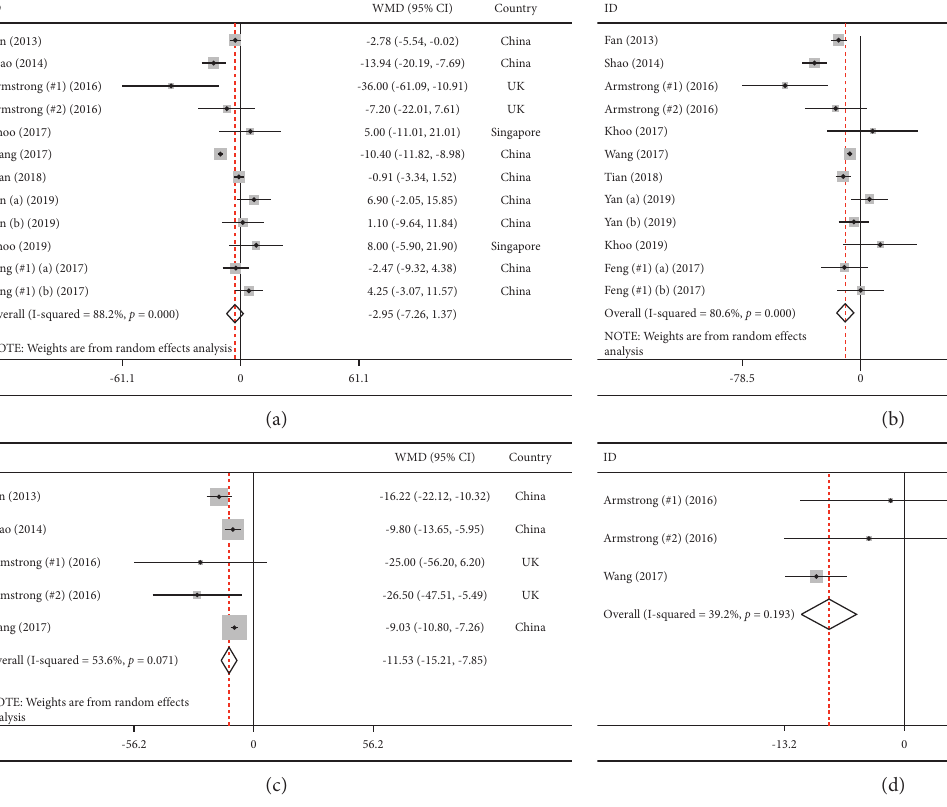
Figure 4: Meta-analysis of weighted mean differences estimates for liver enzymes including (a) aspartate aminotransferase, (b) alanine aminotransferase, (c) gamma-glutamyltransferase, and (d) alkaline phosphatase in intervention and placebo groups (CI �